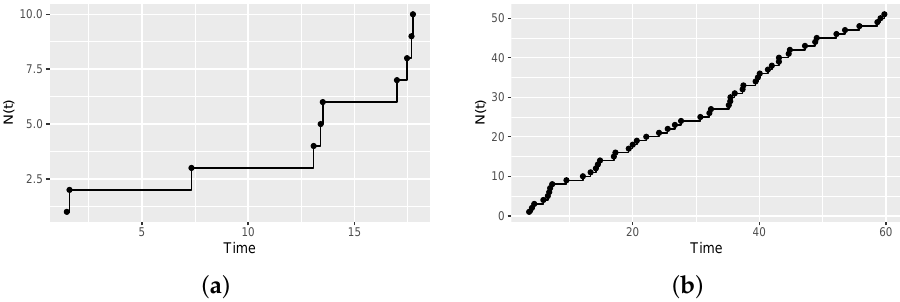
Figure 3. Simulation of a Cox process with Folded Normal intensity function with parameters µ = 0, σ 2 = 1 and with covariance function k Z ( h ) = e − 0,15 | h | for T = 20 ( a ) and T = 60 ( b ).